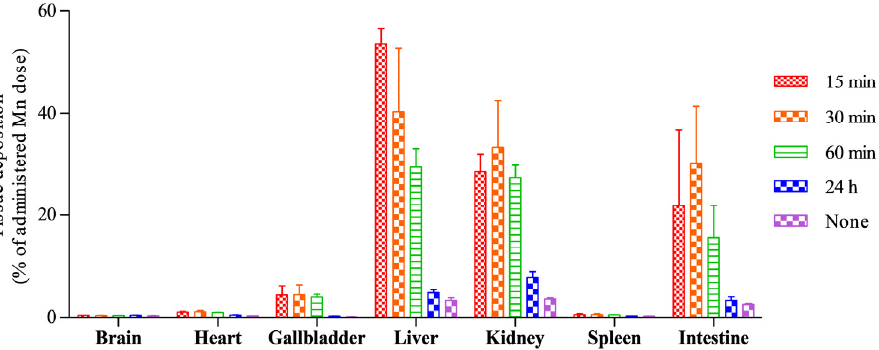
Figure 5. In vivo biodistribution patterns of Mn-NOTA-NP (0.05 mmol Mn/kg) in Balb/c mice, expressed as the percentage of Mn concentrations in each tissue ( n = 4). Mice were sacrificed at 15 min, 30 min, 60 min, and 24 h. Untreated mice served as controls and were labeled as “None.” Data are presented as mean ± SD.